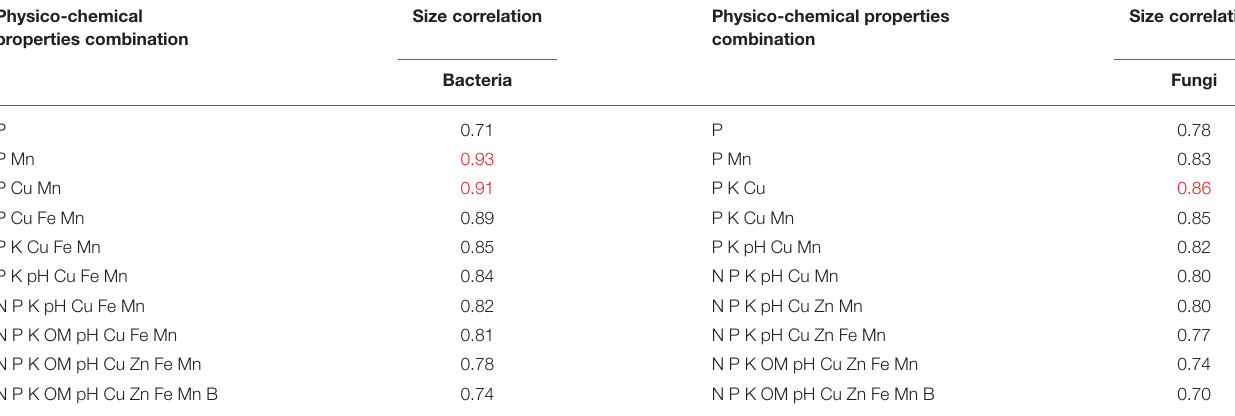
Size correlation Physico-chemical properties